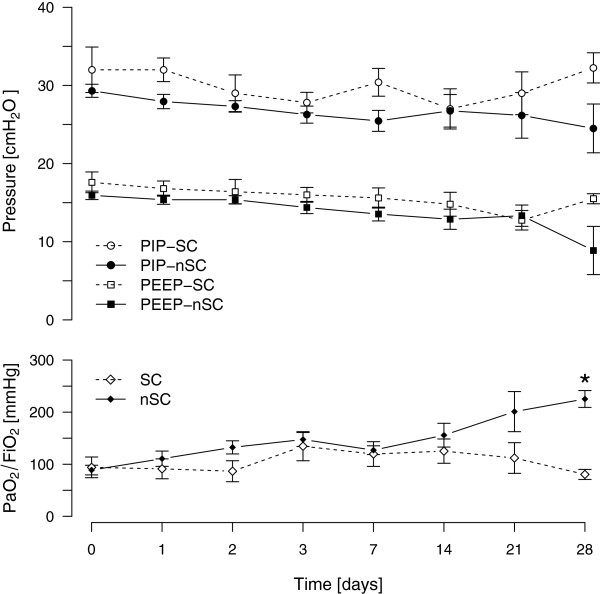
Ventilator settings and respiratory function indicated by peak inspiratory pressure (PIP), positive end-expiratory pressure (PEEP) and ratio of partial arterial oxygen pressure to the fraction of inspired oxygen (PaO2/FiO2). * indicates significant difference (P < 0.001).